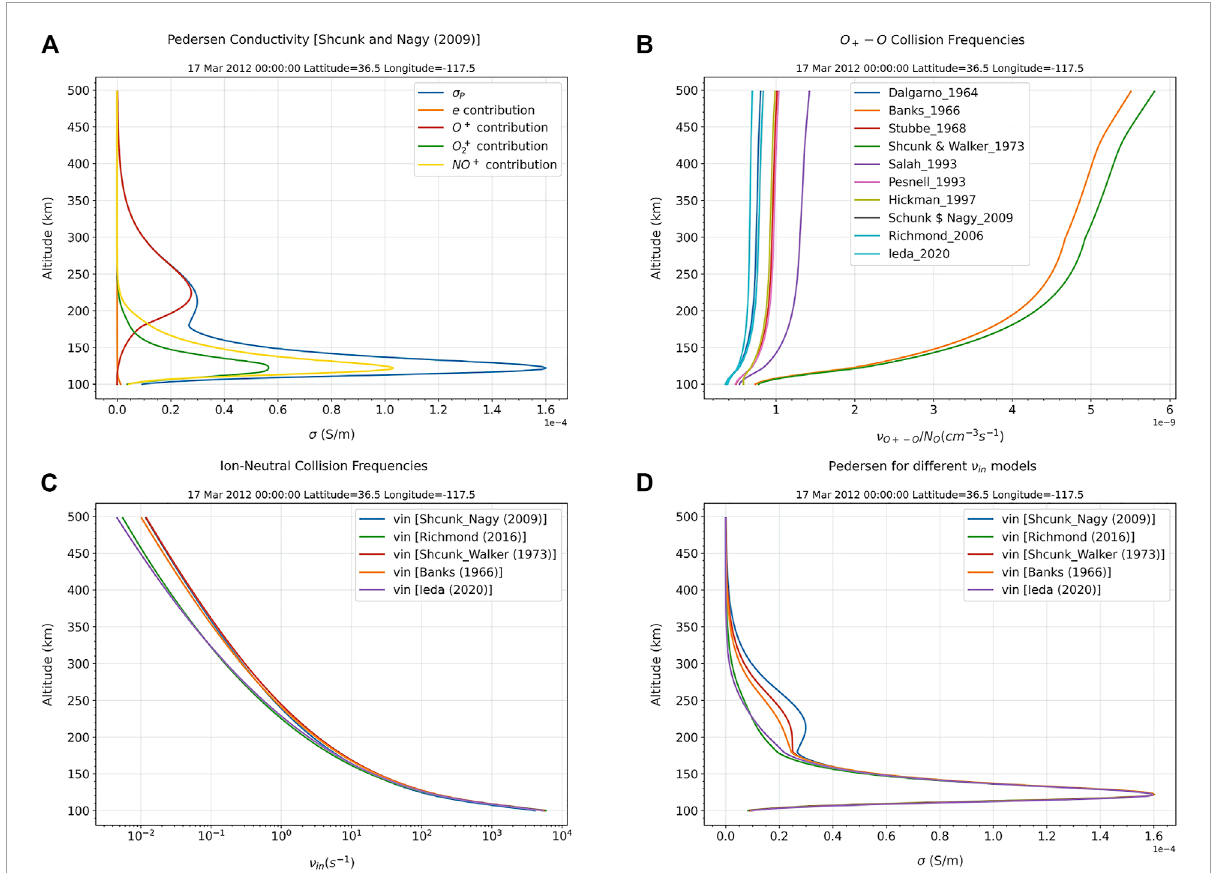
FIGURE 4 (A) Electron and ion contributions to the Pedersen conductivity (B) Normalized collision frequencies of O + − O as a function of altitude, based on the various models, as marked; (C) altitude profiles of the ν in collision frequencies during St. Patrick’s day 2015 storm; and (D) altitude profiles of the Pedersen conductivity, calculated with ν in from different models as